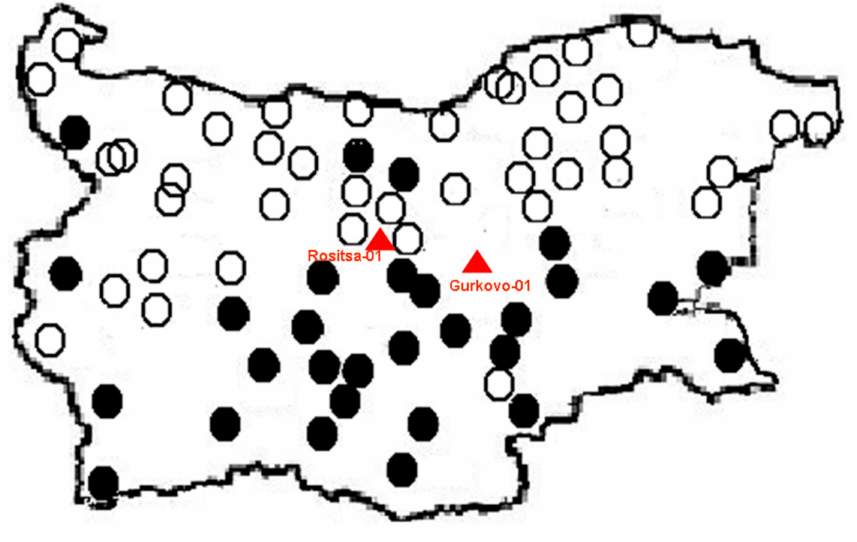
Figure 3. The 20–22 year solar–climatic cycle manifestation in the warm half-year precipitation sums on the territory of Bulgaria (1899–1979 AD). The meteorological station locations where the 20–22 year cycle is statistically significant are signed by black filled circles, the other ones- by empty circles; The “Gurkovo-01” and “Rositsa-01” beech samples locations are signed by red